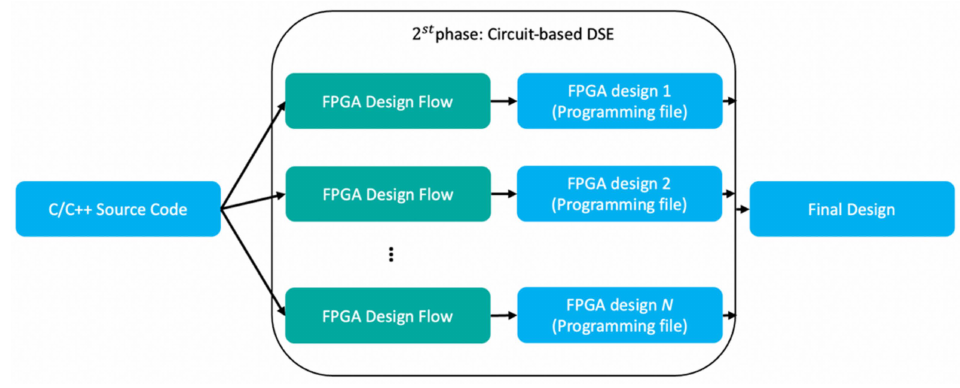
Figure 12. Two-stage design space